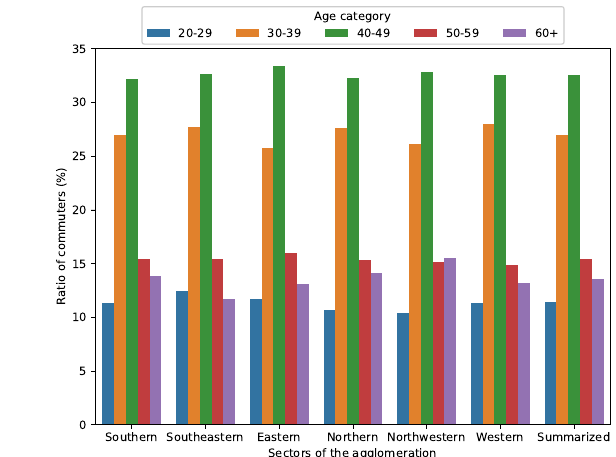
( b ) Distribution of the commuters by age categories and the sectors of the agglomeration (%), based on the CDR